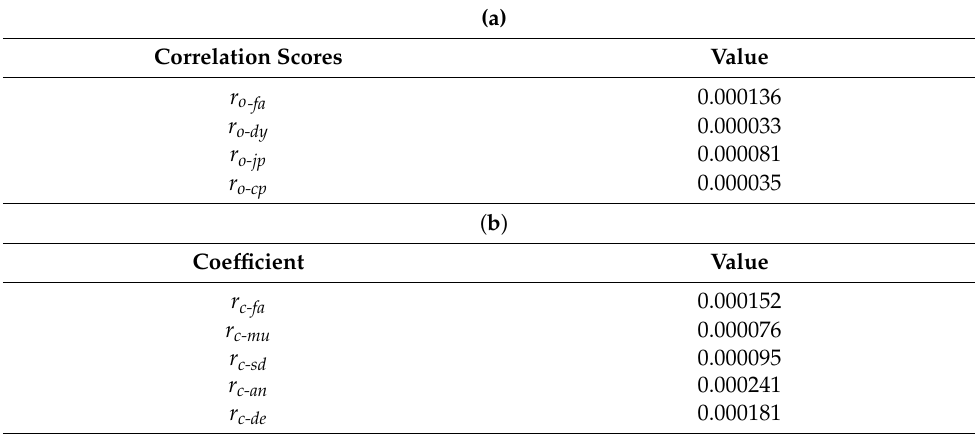
Table A2. ( a ). Correlation scores between COVID-19 and long-COVID symptoms in Europe. ( b ). Corre- lation scores between COVID-19 and long-COVID symptoms in